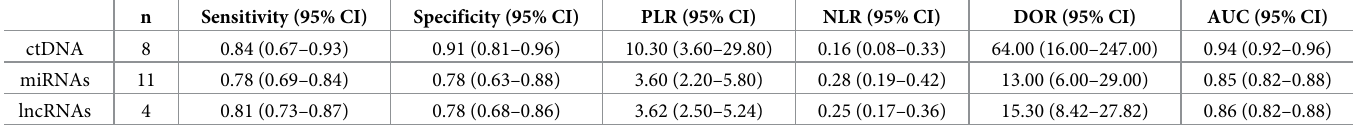
Table 2. Diagnostic efficacy of ctDNA, miRNAs and lncRNAs in OC.